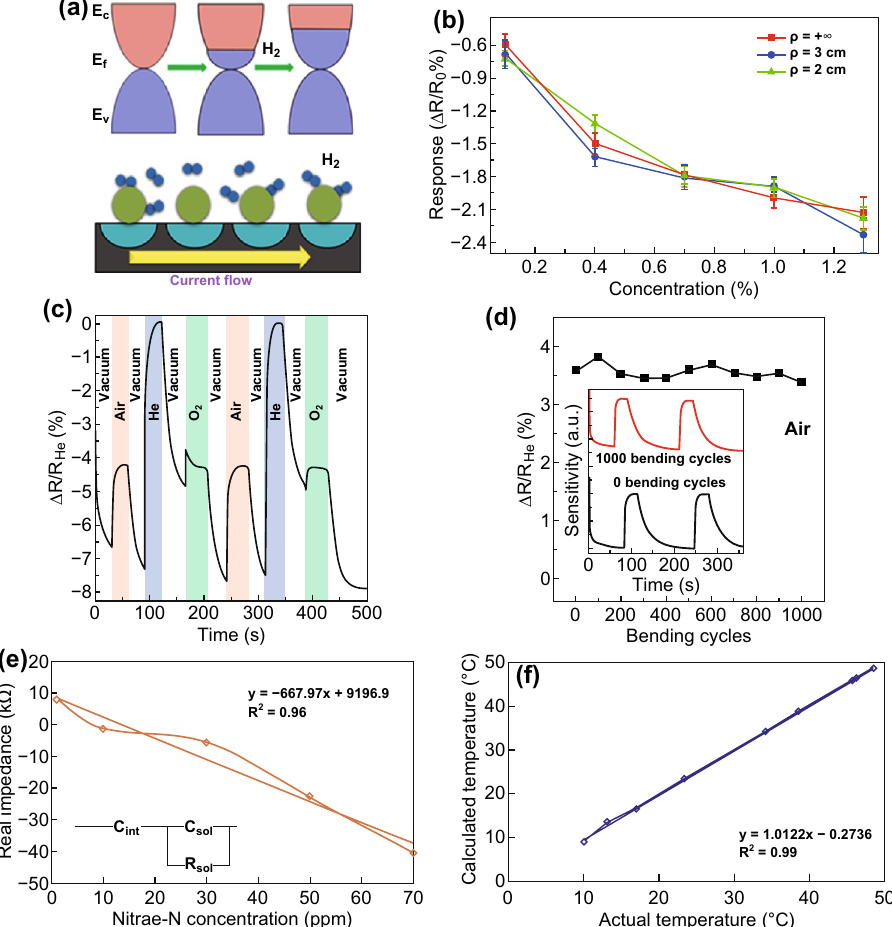
Fig. 6 Non-specific binding sensors from the intrinsic and extrinsic properties. a Band energy analysis of the H 2 gas acting onto LIG (top) and catalytic reaction of H 2 on LIG/Pd (bottom). b Response versus H 2 concentration with different bending states. a , b Adapted with the permis- sion from Ref. [65], Copyright 2019 American Chemical Society. c Responses of gas sensor toward a variety of gases. d Magnitude of response of gas sensor to air after bending it with a radius of curvature of 7 mm. Inset figure shows the response of the gas sensor to air after 0 and 1000 bending cycles. c , d Adapted with the permission from Ref. [47], Copyright 2019 American Chemical Society. e Nitrate sensor response to the nitrate concentration. Inset is the equivalent circuit of sensor immersed in solution. f Comparison of actual and measured temperature. e , f Adapted with the permission from Ref. [68], Copyright 2017 Elsevier